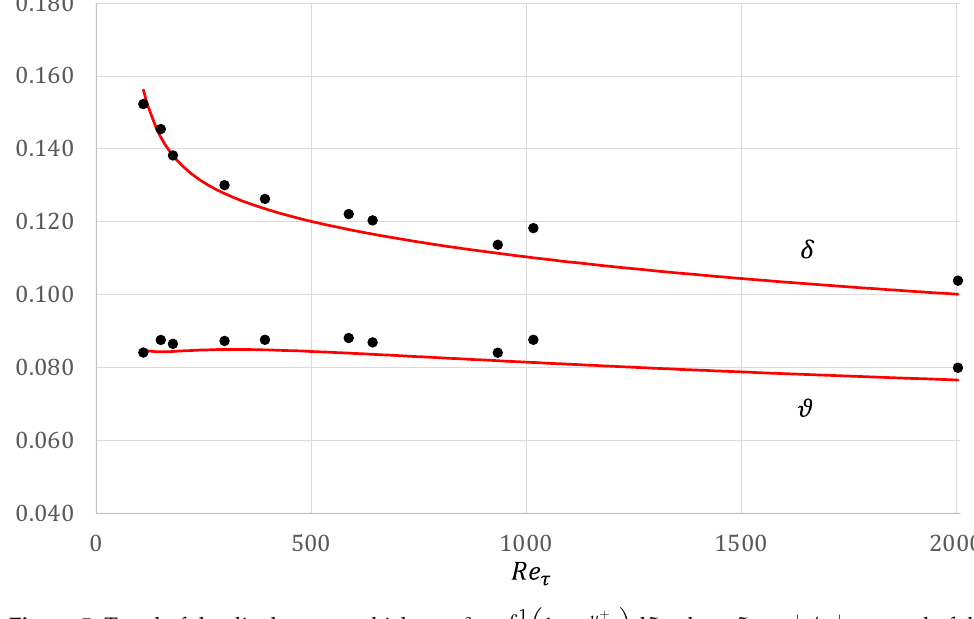
Figure 5. Trend of the displacement thickness δ = momentum thickness ϑ =